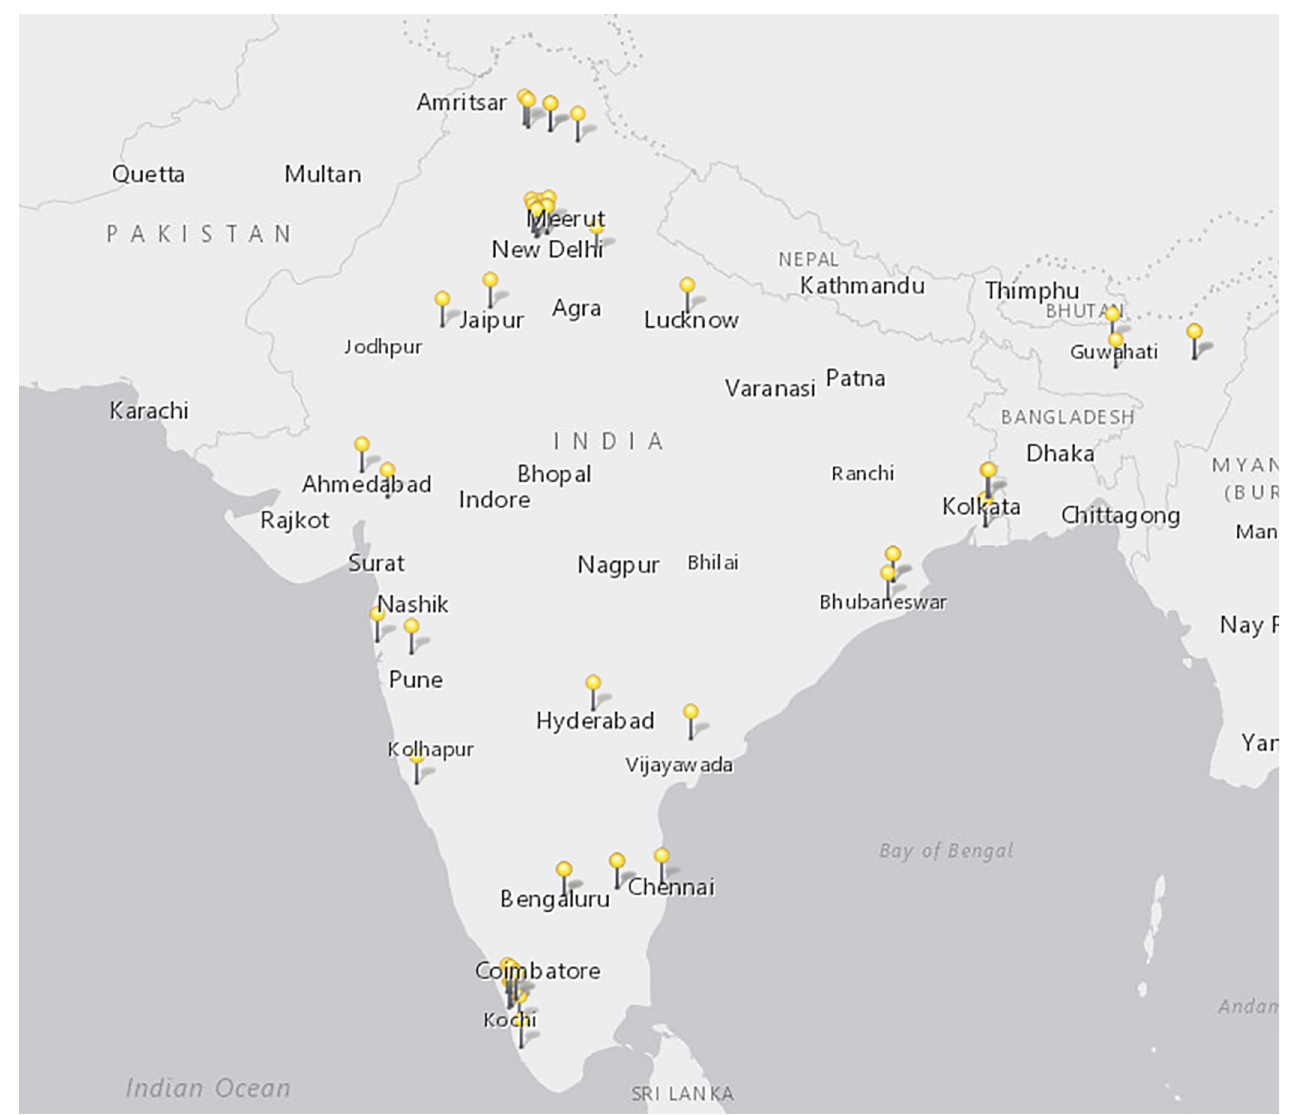
Fig 2. Map of institutions offering education and training programs across India.